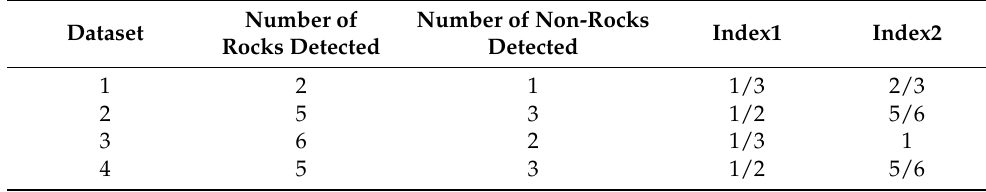
Table 3. Index calculation results of the four sets of